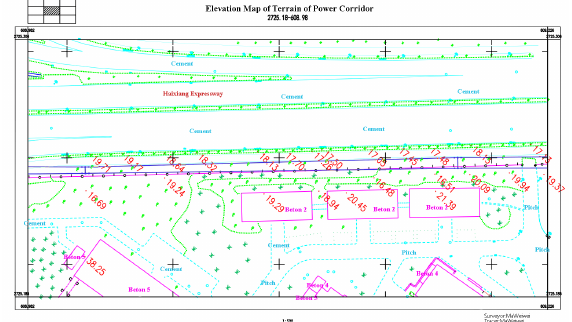
Figure 12. Elevation map of terrain of power corridor